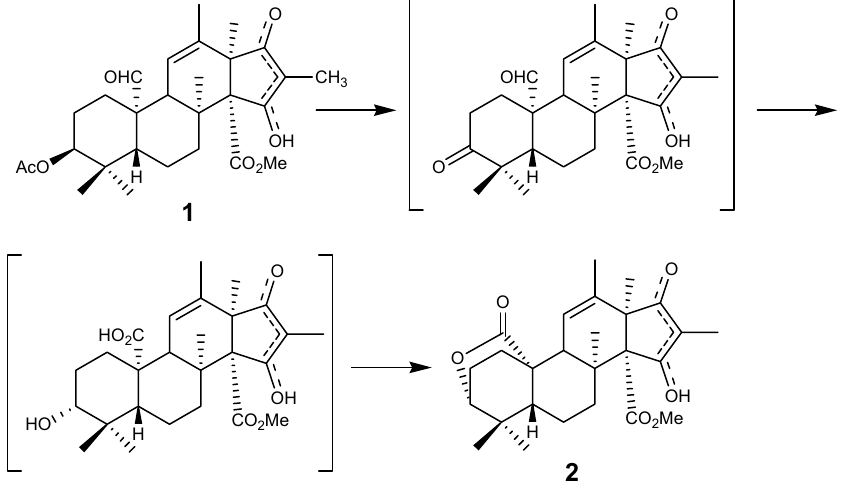
Figure 3. Proposed biosynthetis of atlantinone A ( 2 ) starting from andrastin A ( 1 ).